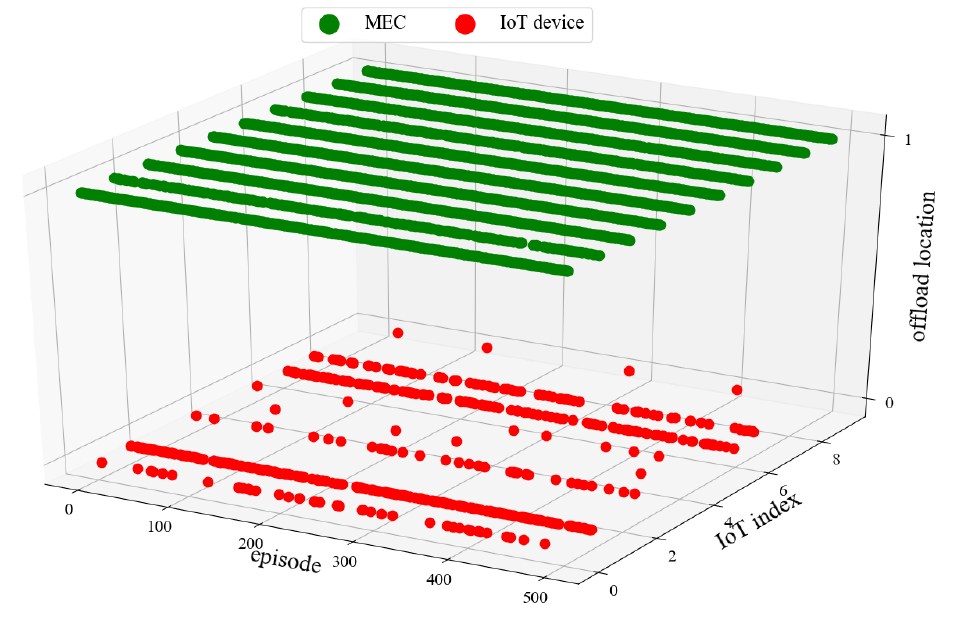
Figure 10. System bandwidth B = 10